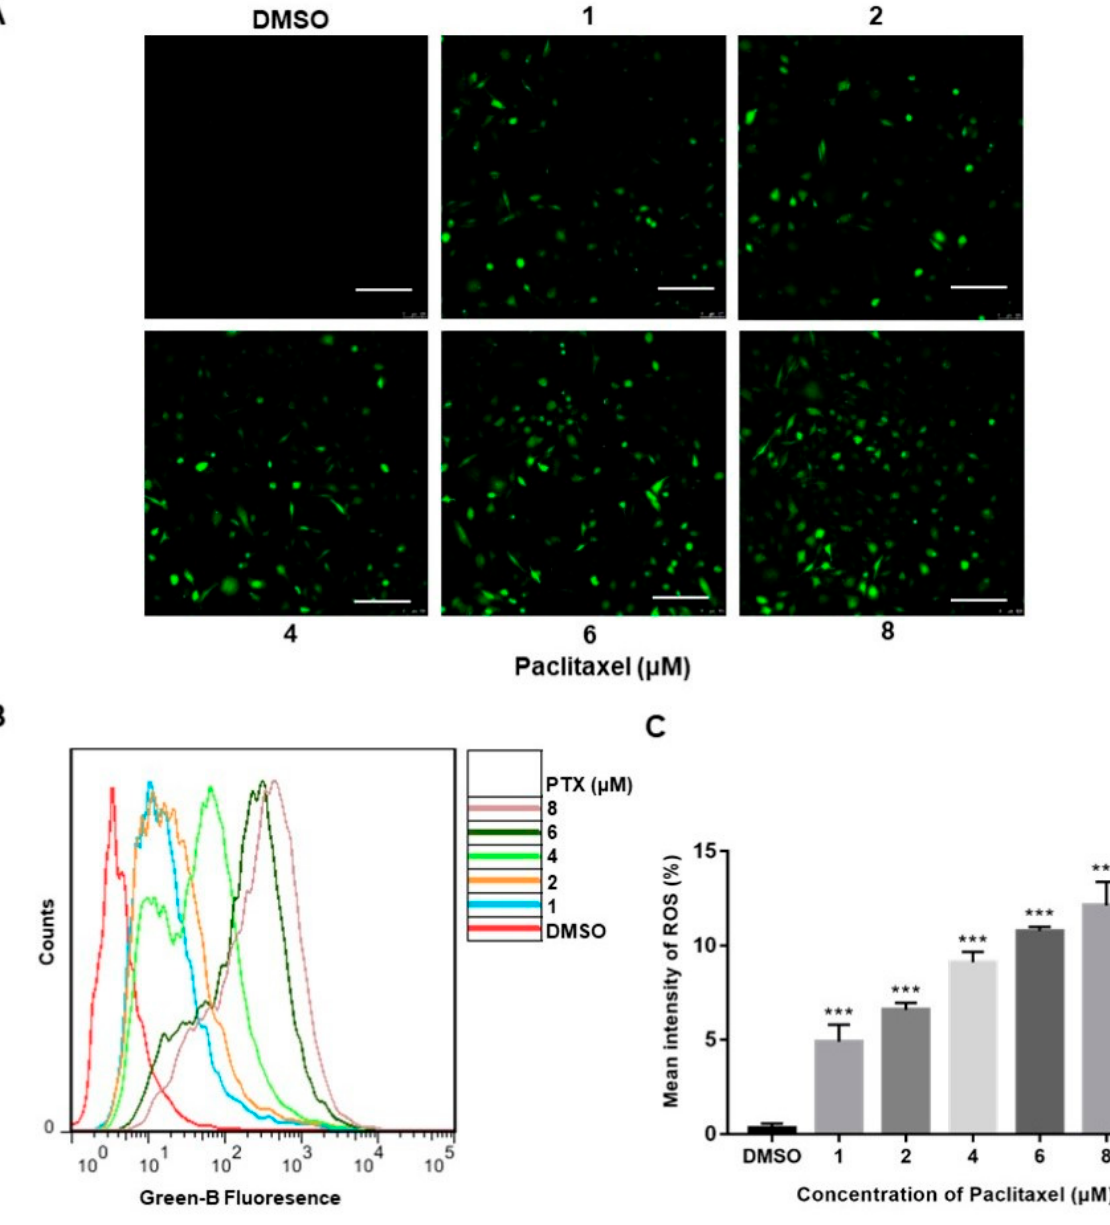
Figure 2. Paclitaxel-induced ROS generation in PC3M Cells. ( A ) Paclitaxel-induced ROS generation evaluated by fluorescence microscope with DCFH-DA. Scale bars = 100 µ m. ( B ) ROS levels induced by paclitaxel were measured by flow cytometer. ( C ) ROS levels in each treatment were analyzed statistically and presented in the form of bar graphs in three independent experiments. Results are expressed as mean ± SD, n = 3. ***: p < 0.001.